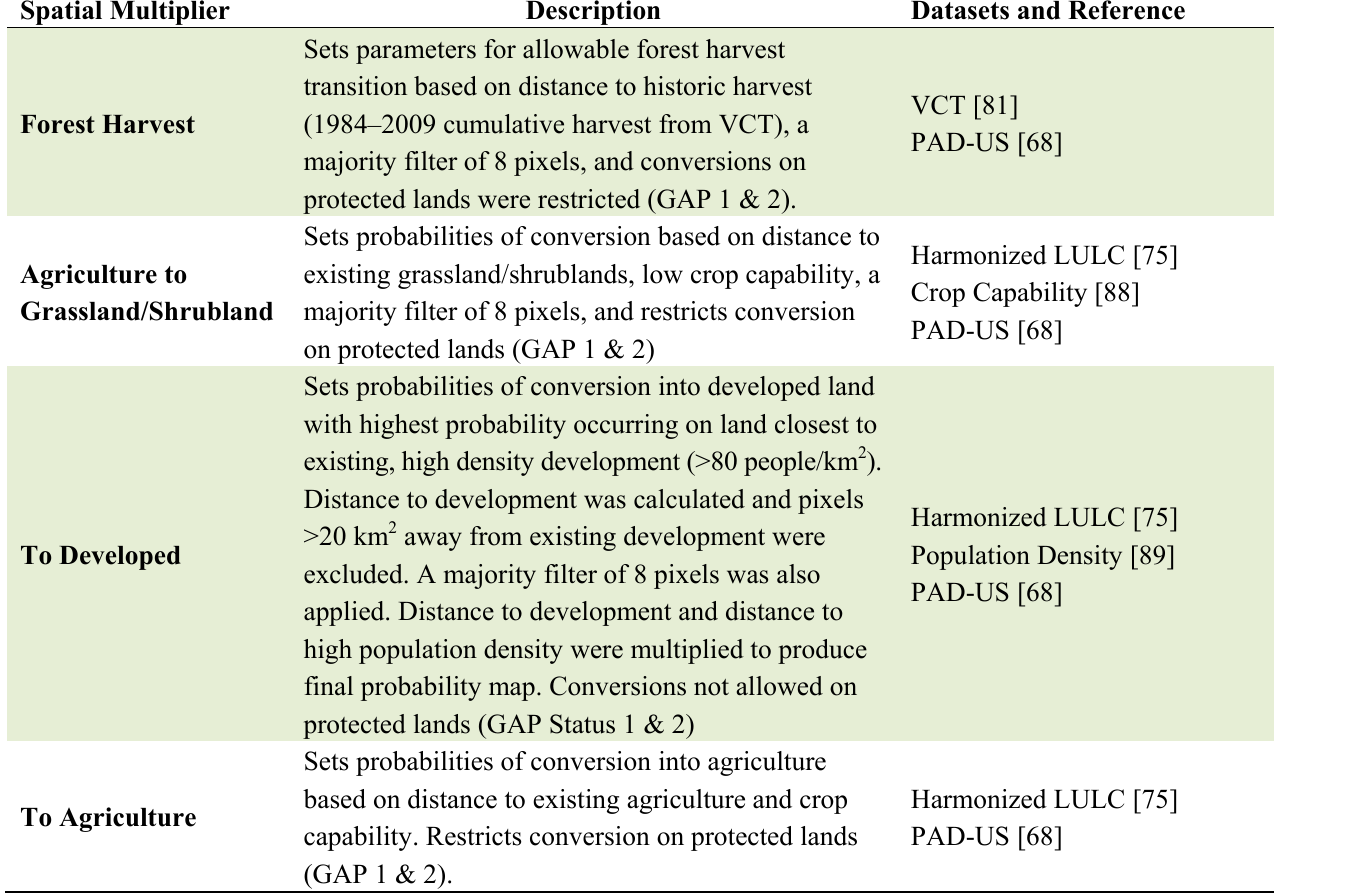
Table 2. Spatial multipliers developed to spatially constrain land-use